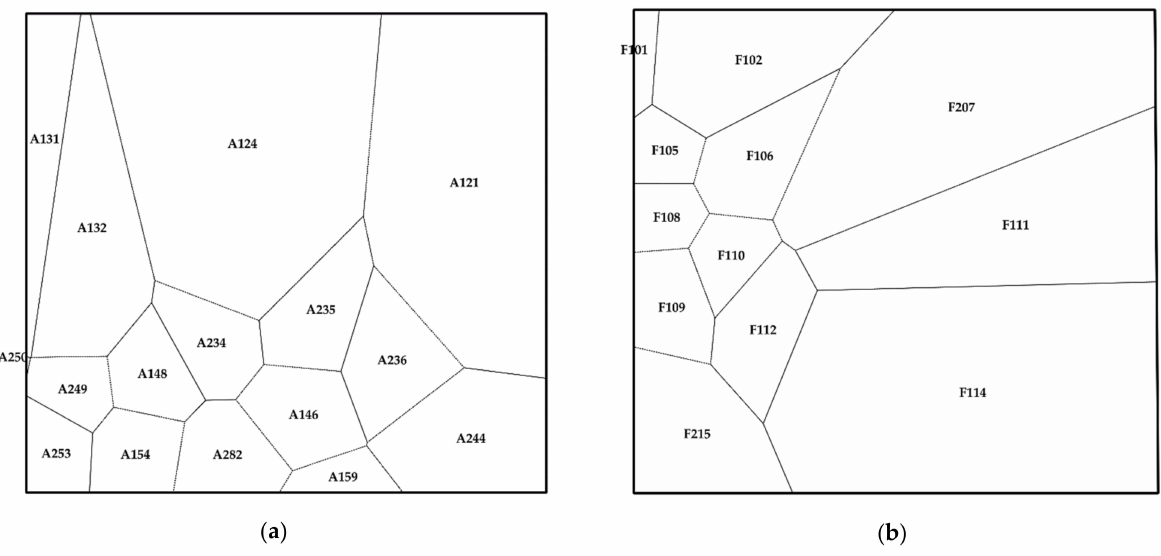
Figure 2. Thiessen polygons of ( a ) LWREW and ( b ) FCREW were used for weighing the in situ